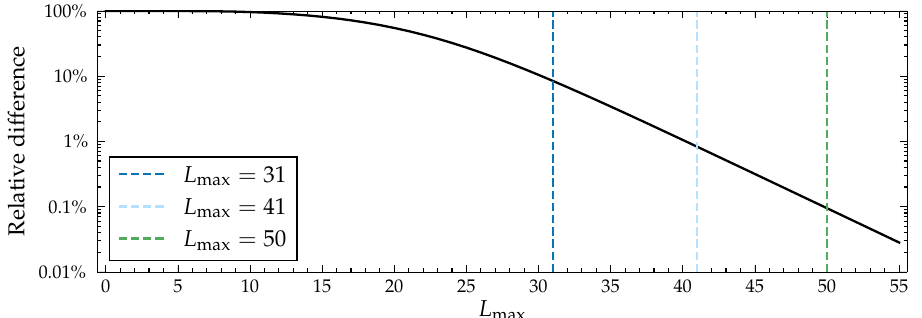
Figure 2. Relative difference in out-centrality values with different path lengths when compared to the values with L max → ∞ in the Facebook network [25] calculated with the CC model (Algorithm 2) when w ( u , v ) = 0.1 for all ( u , v ) ∈ E , λ = 1, and T → ∞ . By relative difference, we mean the largest relative difference in a node’s out-centrality value when compared to the converged value, i.e., those with L max → ∞ . Note that the y-axis is logarithmic and that the curve is nearly linear after the start, which means that precision grows exponentially with respect to path length.